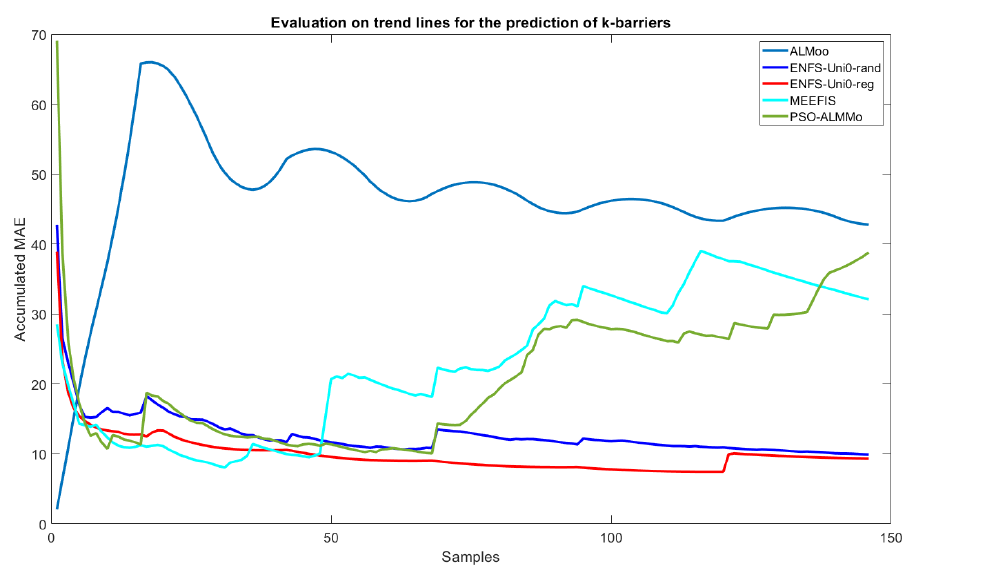
Figure 5. Result in trend lines for the evaluation of the k-barriers